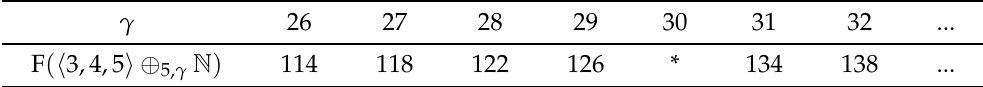
Table 3. Values γ such that gcd ( 5, γ ) (cid:54) = 1 are marked with *.